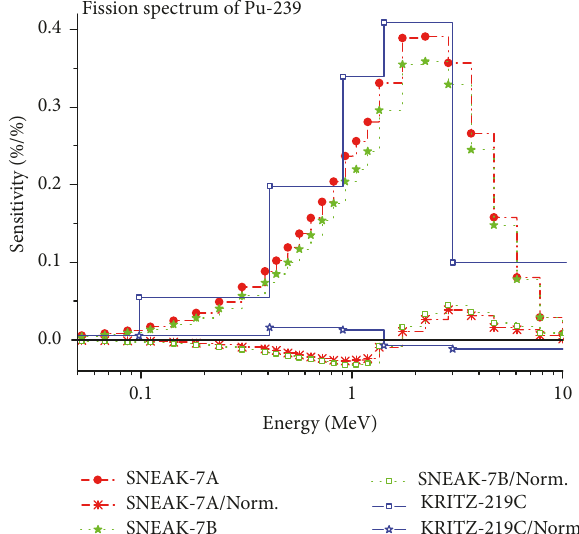
Figure 5: Examples of the sensitivities with respect to the PFNS of 239 Pu calculated by the constrained (/Norm.) and unconstrained sensitivity methods (SNEAK-7 and KRITZ